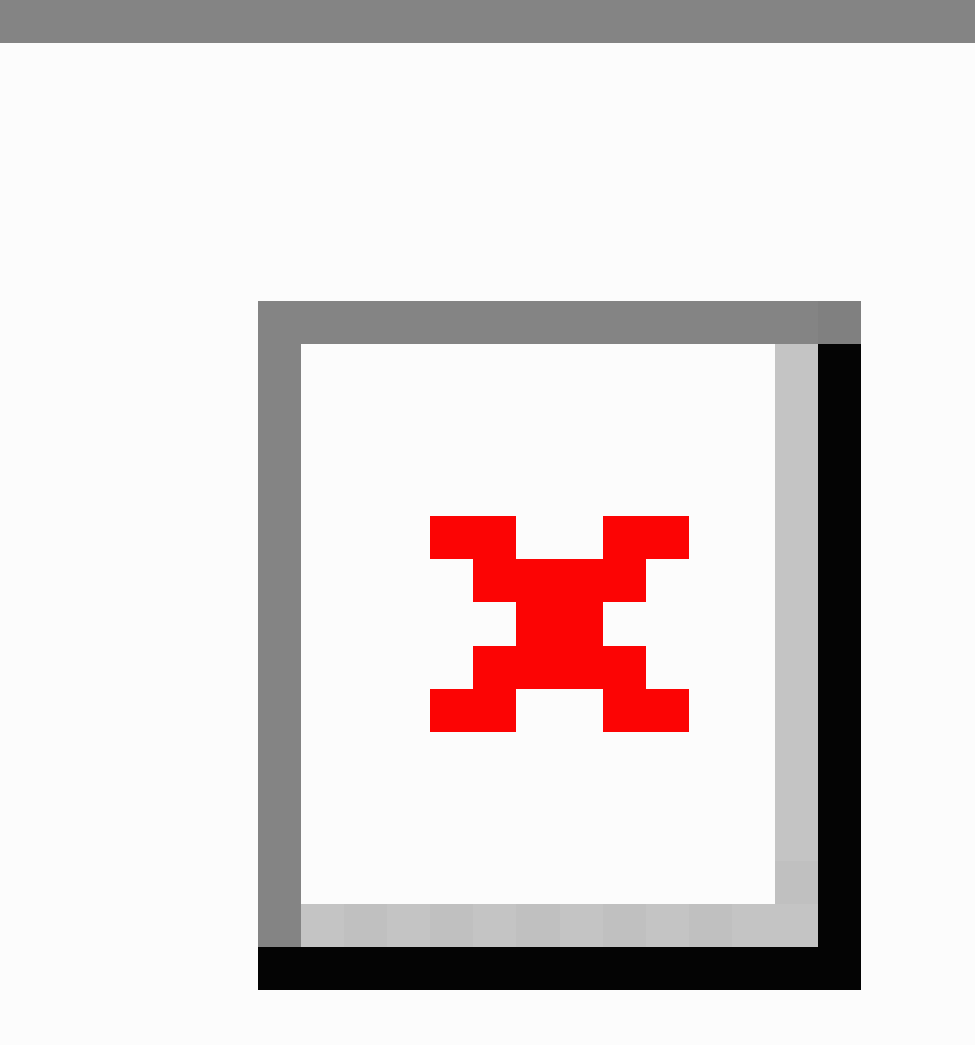
Figure 2. Digitally aged photos of female participant at 65 years as a nonsmoker (left) and as a smoker